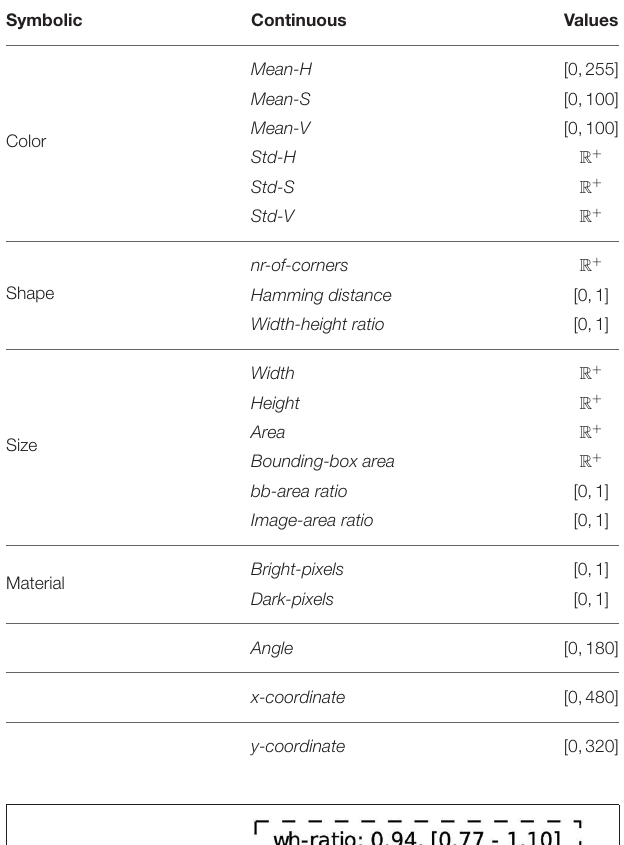
TABLE 3 | Mapping from symbolic attributes to continuous attributes obtained by the image segmentation process. Symbolic